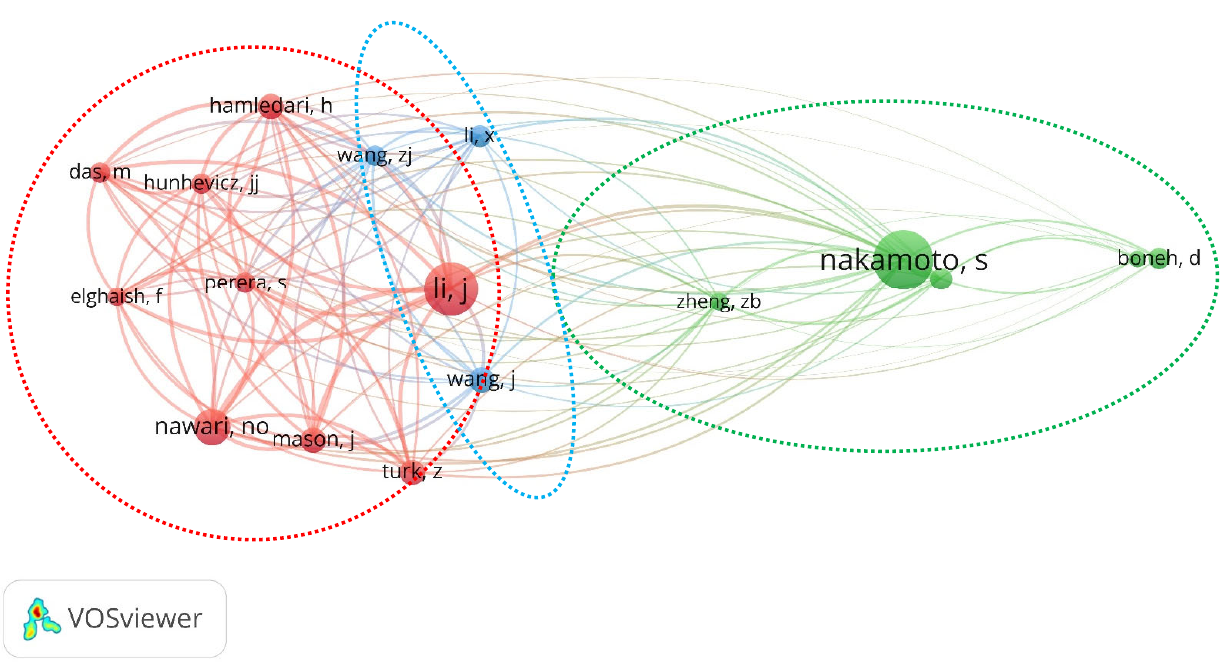
Figure 11. Network visualization of co ‐ citation.